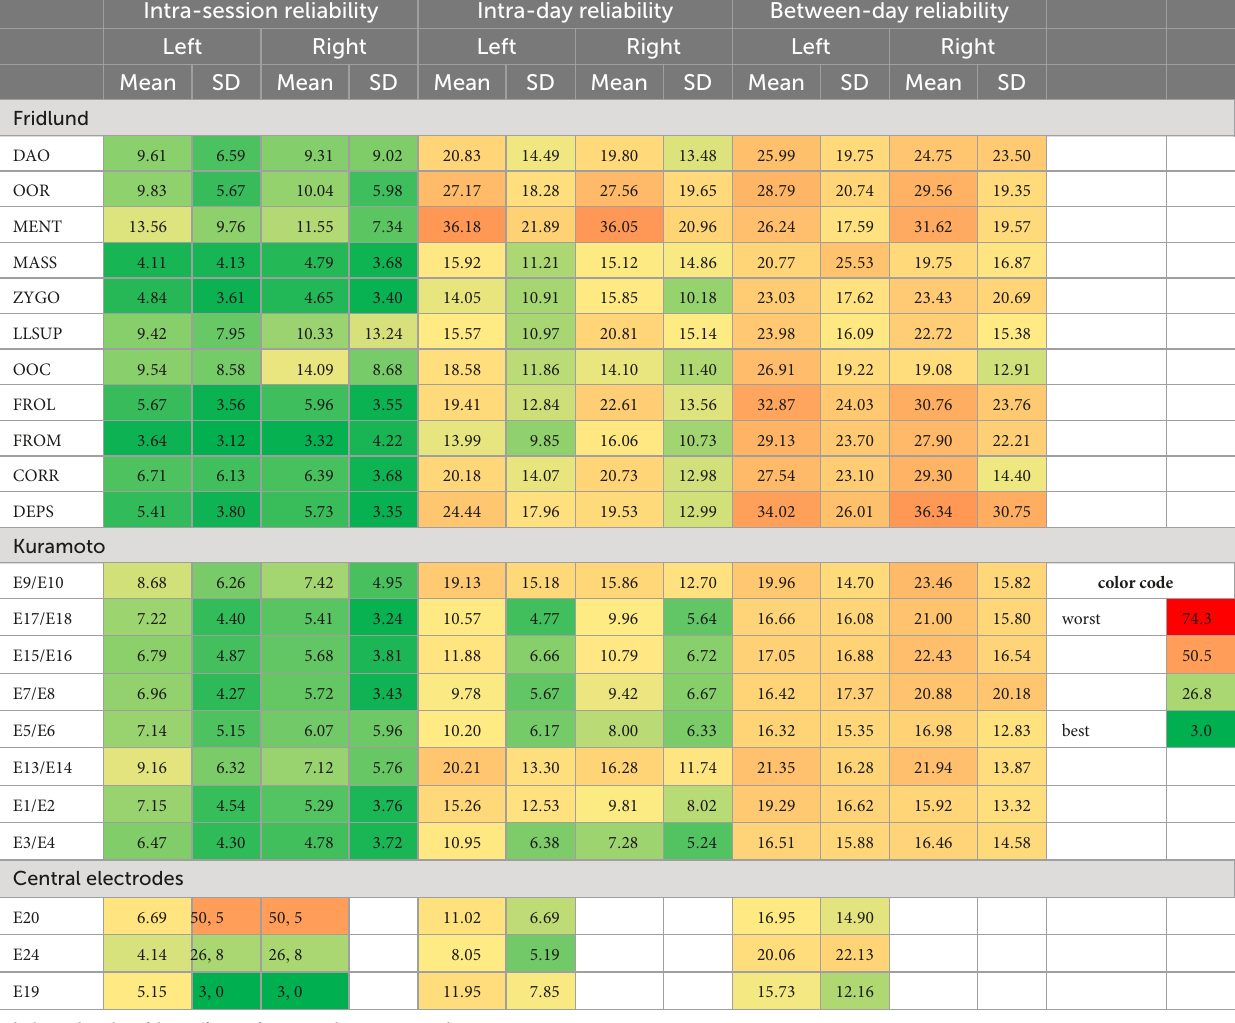
TABLE 3 Coefficient of variation statistics: Test and re-test reliability of the surface EMG recordings from the different facial muscles*. Intra-session reliability Intra-day reliability Between-day